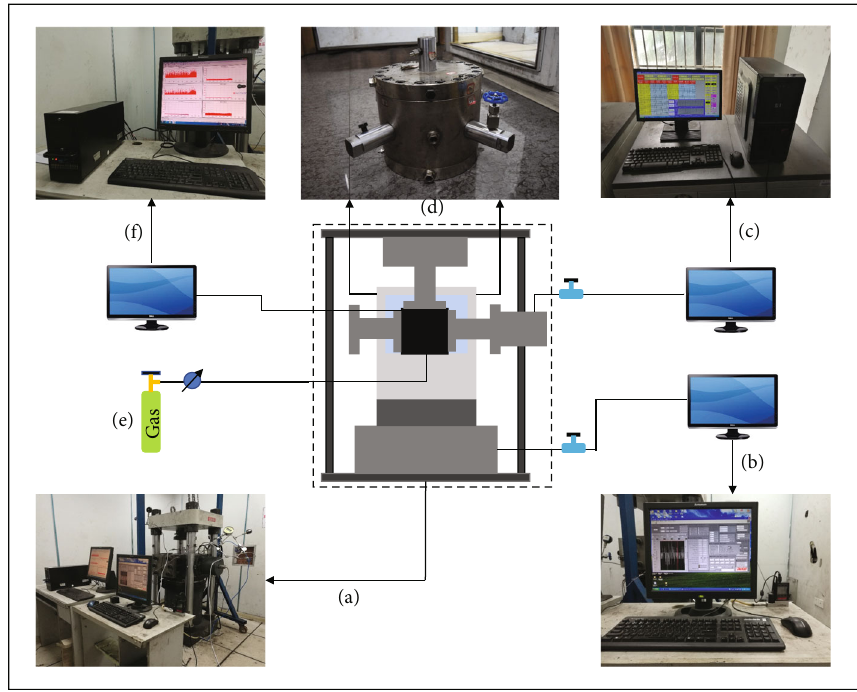
Figure 1: Diagram of experimental